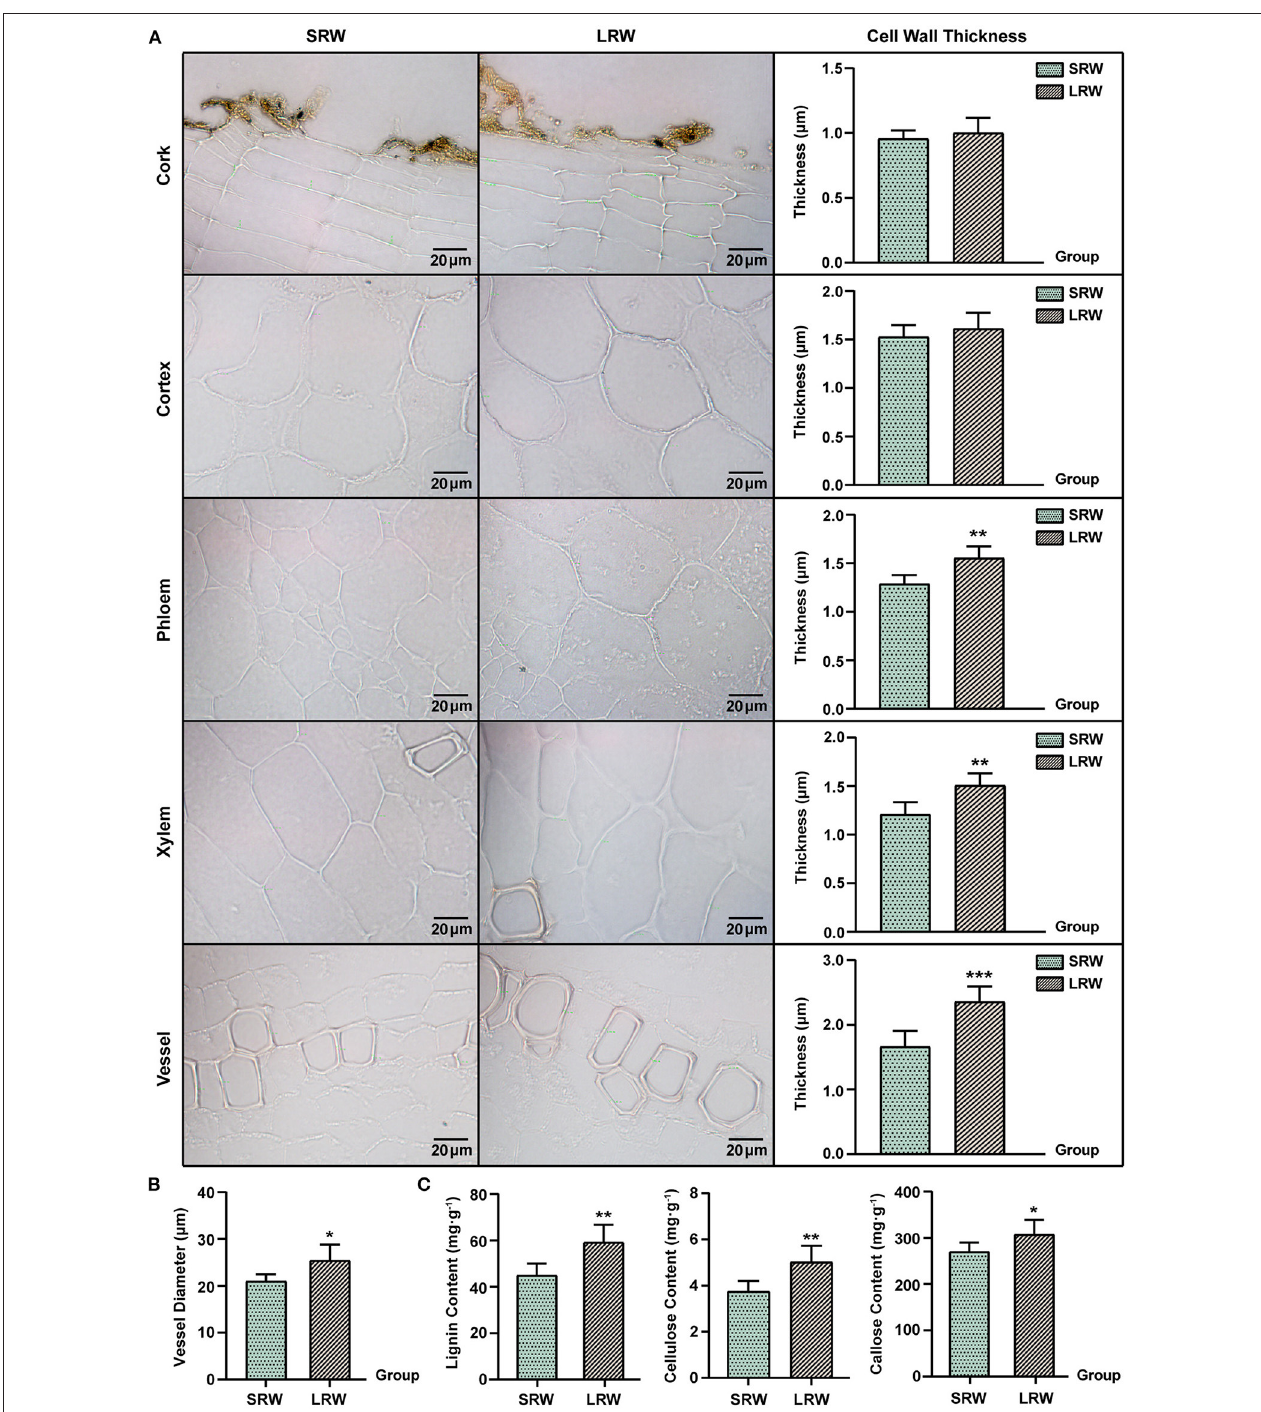
FIGURE 2 | Different tissues and cell morphology in P. notoginseng . SRW was an abbreviation of small root weight, while LRW represented large root weight. (A) Microscope morphology of different tissues including cork, cortex, phloem, xylem, and vessel, and comparison of the cell wall thickness. (B) Comparison of the vessel diameter of P. notoginseng with different root weights. (C) Determination of lignin and callose in P. notoginseng with different root weights. The thickness of 10 cell walls in one field of view were measured and averaged, and then in accordance with this, a total of six fields of view from five biological replicates were obtained for t -test. Measurement of the vessel diameters was same as that of the cell wall thickness, while the diameter of seven vessels was measured and averaged. Asterisks denote Student’s t-test significance: * P < 0.05 and ** P < 0.01.